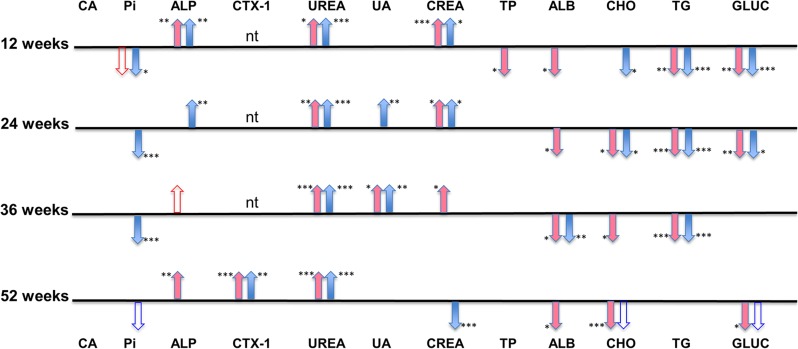
Statistically significantly changed clinical chemical and CTX-1 plasma values of aged groups of Scube3N294K/N294K mice measured at 12, 24, 36, and 52 wk of age. Red or blue filled arrows show significantly increased or decreased plasma values for female and male mice compared to Scube3WT mice (* P ≤ 0.05,** P = 0.01,*** P ≤ 0.001; nt = not tested). Unshaded but red or blue outlined arrows show a tendency to increased or decreased values not reaching statistically significance. Numbers of mice at 12 wk were female Scube3N294K/N294K mice n = 9, female Scube3WT n = 20, male Scube3N294K/N294K mice n = 21, and male Scube3WT n = 34; at 24 wk female Scube3N294K/N294K mice n = 10, female Scube3WT n = 21, male Scube3N294K/N294K mice n = 15, and male Scube3WT n = 29; at 36 wk female Scube3N294K/N294K mice n = 12, female Scube3WT n = 8, male Scube3N294K/N294K mice n = 25, and male Scube3WT n = 33; and at 52 wk: female Scube3N294K/N294K mice n = 12, female Scube3WT n = 8, male Scube3N294K/N294K mice n = 5, and male Scube3WT n = 11. For CTX-1 measurement at 52 wk, numbers were n = 10 mice for both female Scube3N294K/N294K mice and Scube3WT mice, male Scube3N294K/N294K mice n = 9, and male Scube3WT mice n = 10. ALB, albumin; ALP, total alkaline phosphatase; Ca, total inorganic calcium; CHO, cholesterol; CREA, creatinine; CTX-1, carboxy-terminal collagen crosslinks; GLUC, glucose; Pi, total inorganic phosphate; TG triglycerides; TP, total protein; UA, uric acid.